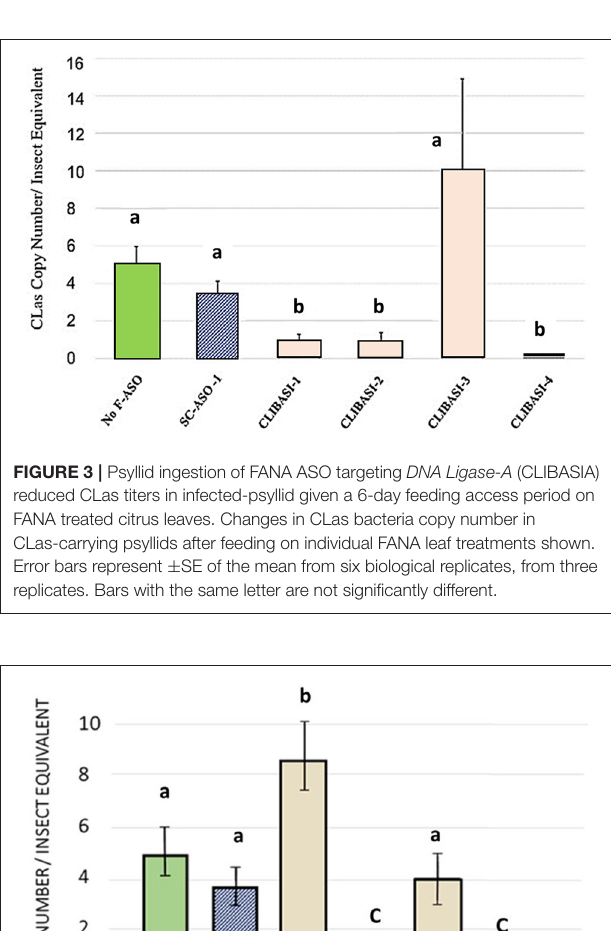
table analyses indicated significant differences in Potato Foliar Symptom Scores of severity among treatments (row mean score